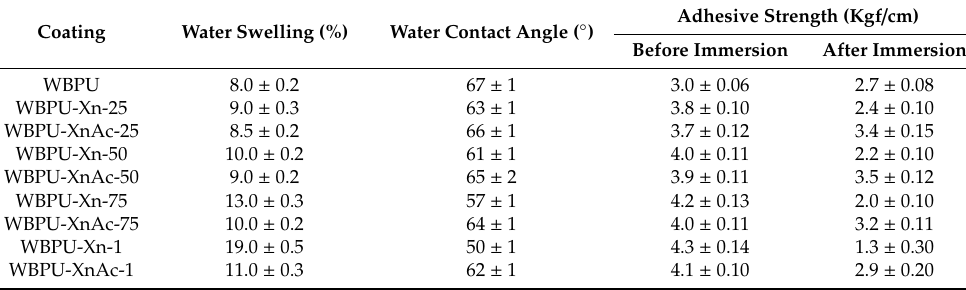
Figure 5. Water contact angle of coatings with different contents of Xn and XnAc. Table 3. WBPU coating properties.